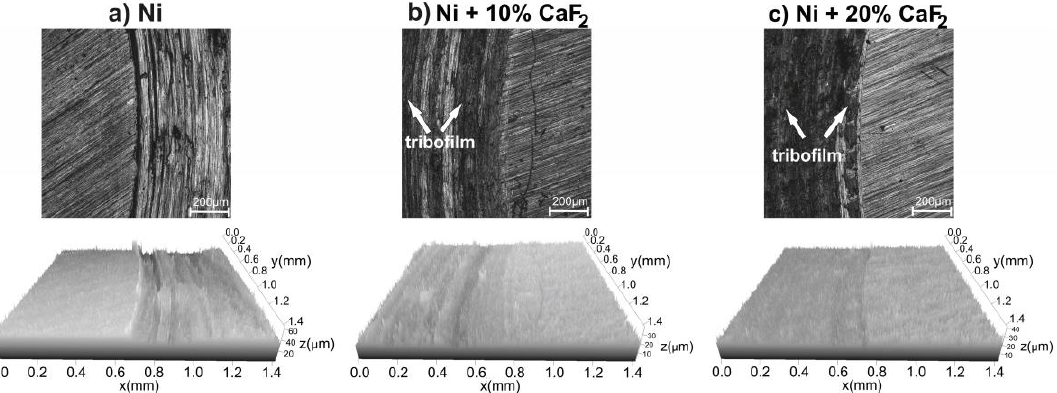
Figure 7. Stereometrics profiles of counter-specimens mated with produced sinters, after wear test at 200 °C.